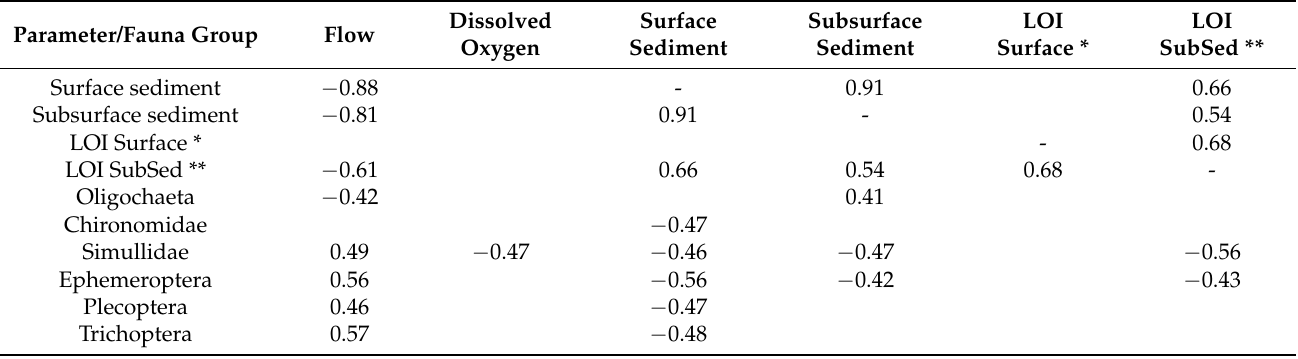
Table 4. Spearman correlation coefficients between the values of environmental variables and density of benthic macroinvertebrates in the Por˛ebianka and Mszanka rivers (in total). Significant at p < 0.05. Only significant correlations are given. Abbreviations: DO—dissolved oxygen, * LOI Surface—LOI in surface sediment, ** LOI SubSed—LOI in subsurface